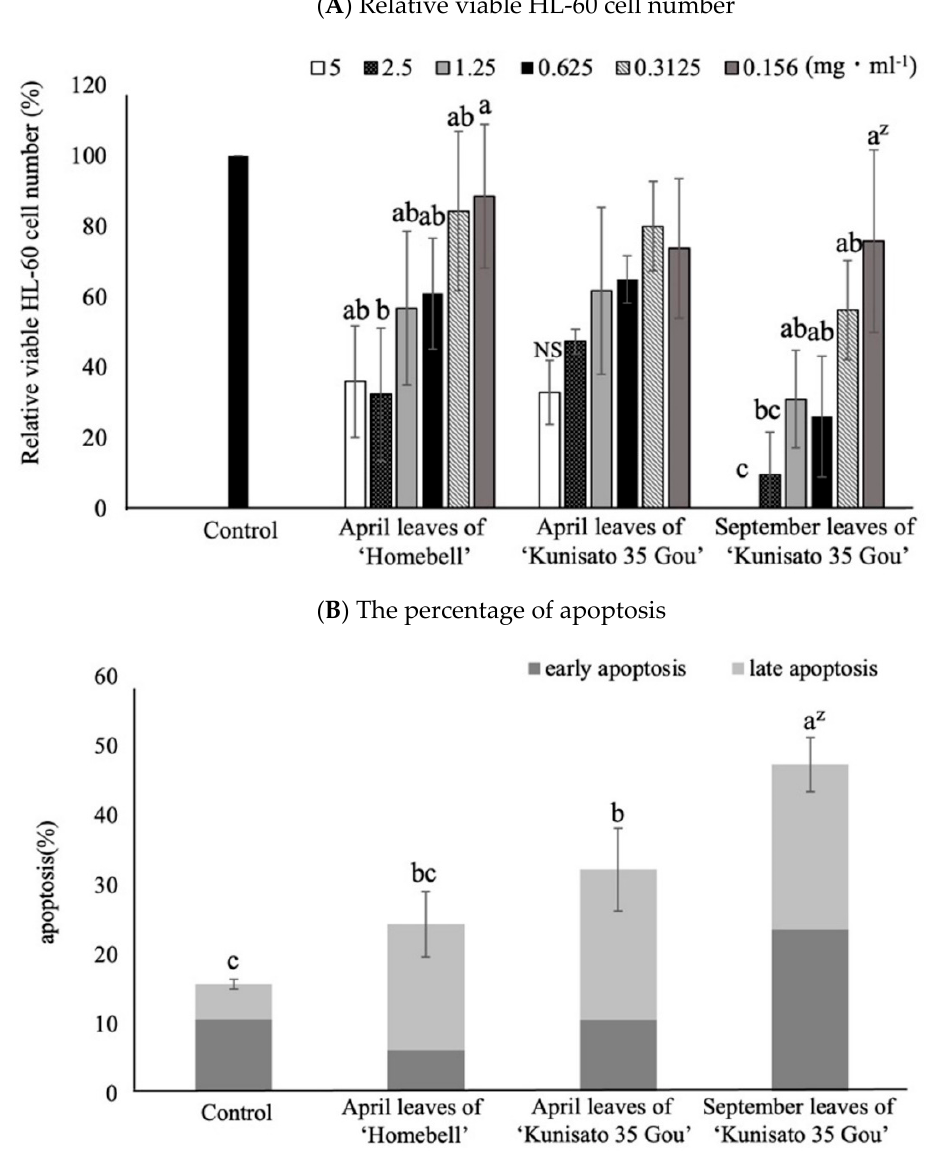
Figure 7. Effects of blueberry leaf extracts on the anti-cancer cell proliferation properties and apoptosis in HL-60 cells (human promyelocytic leukemia cells). ( A ). Comparison of the relative viable HL-60 cell numbers (survival rates) against leaf extracts of ‘Homebell’ in April and ‘Kunisato 35 Gou’ in April and September. Only HL-60 cells were used without adding extract as a control. z Different letters among 6 concentrations represent significant differences at 5% level as determined by Tukey’s multiple range test (n = 3). The relative viable cell number was determined and expressed as % of the viability of cells of the control, which was determined as 100%. ( B ) The early/late apoptosis rate against leaf extracts of rabbiteye blueberry ‘Homebell’ in April and ‘Kunisato 35 Gou’ in April and September. z Different letters among varieties each month represent significant differences at 5% level as determined by Tukey’s multiple range test (n = 3). Only HL-60 cells were used without adding extract as a